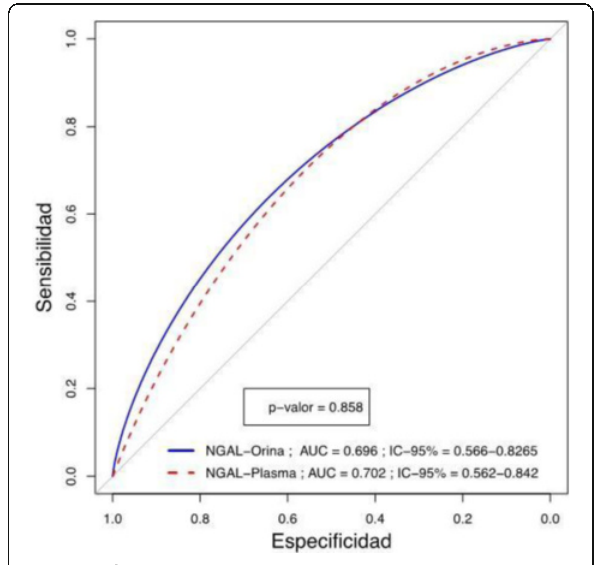
Fig. 112 (abstract A286). ROC`s